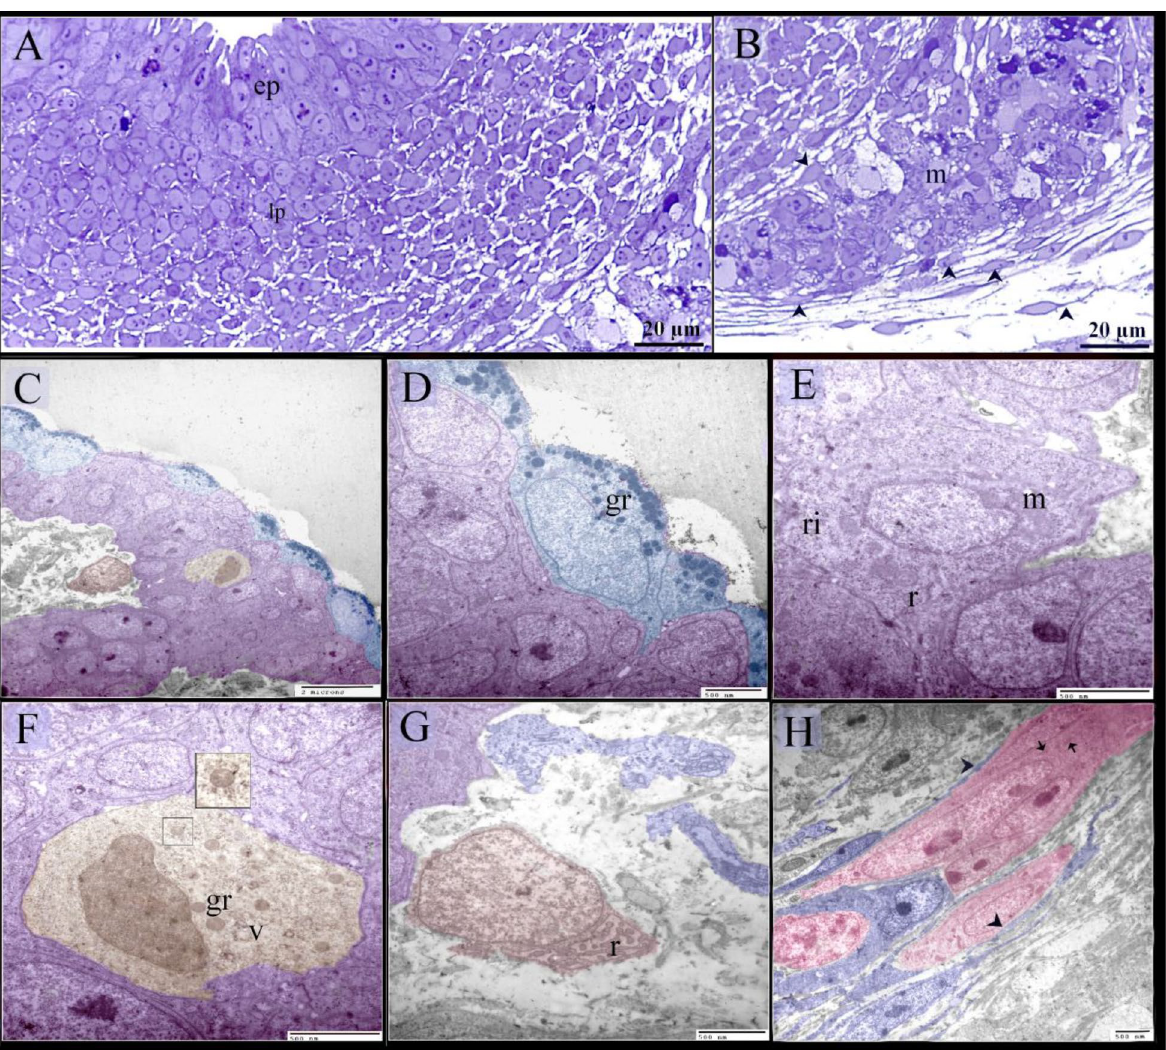
Figure 8. Semi-thin sections and ultrastructure at day 8. Semi-thin sections ( A , B ) stained with methylene blue. Ultramicrograph of the esophagus ( C–H ) A: pseudostratified epithelium (ep). Mesenchymal condensation in the lamina propria (lp). ( B ) Myoblasts (m) aggregation at the prospective site of the muscular layer. Note telocytes (arrowheads). ( C ) Pseudostratified epithelium had superficial mucous-secreting cells (blue colored). Putative dendritic cell (golden color) had vesicles (v) and granules (gr). Interstitial cell (brown color). ( D ) Superficial mucous-secreting cells (blue colored) contained mucous granules (gr). ( E ) Epithelial cell contained RER (r), ribosomes (ri), mitochondria (m). ( F ) Putative dendritic cell (golden color) had vesicles (v) and granules (gr). ( G ) Interstitial cell (brown) had dilated RER (r), note telopodes of telocyte (blue). ( H ) Myoblasts (pink) aggregation surrounded by telocytes (blue). Note telopodes